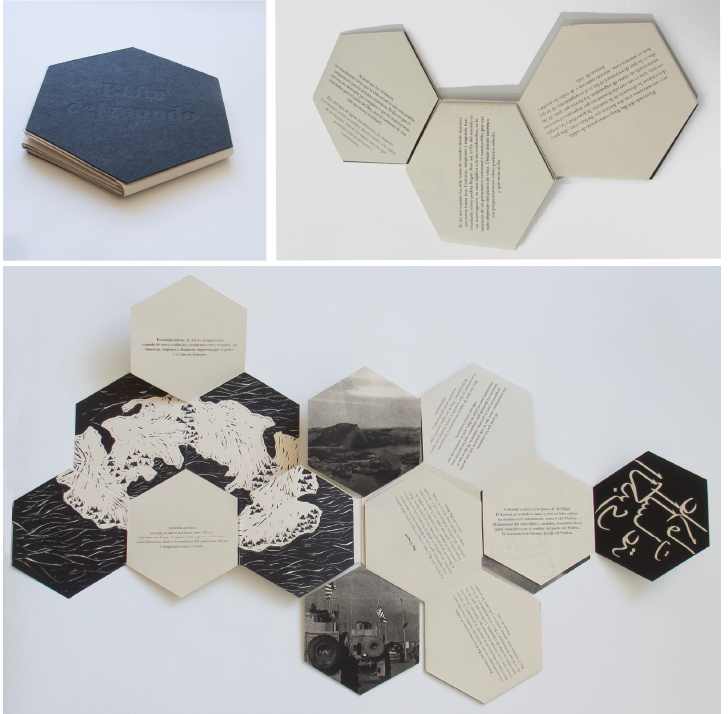
Figure 2. Andorrà, A, Koriachi, M., Ruíz, M. El fin del mundo, 2019, Edition of 6, Lithography, Linocut Figure 2. Andorr à , A, Koriachi, M., Ru í z, M. El fin del mundo, 2019, Edition of 6, Lithography, Linocut and Embossing on Arches, Book closed 12 cm × 14 cm × 1.5 cm) (Photo: Z46). and Embossing on Arches, Book closed 12 cm × 14 cm × 1.5 cm) (Photo: